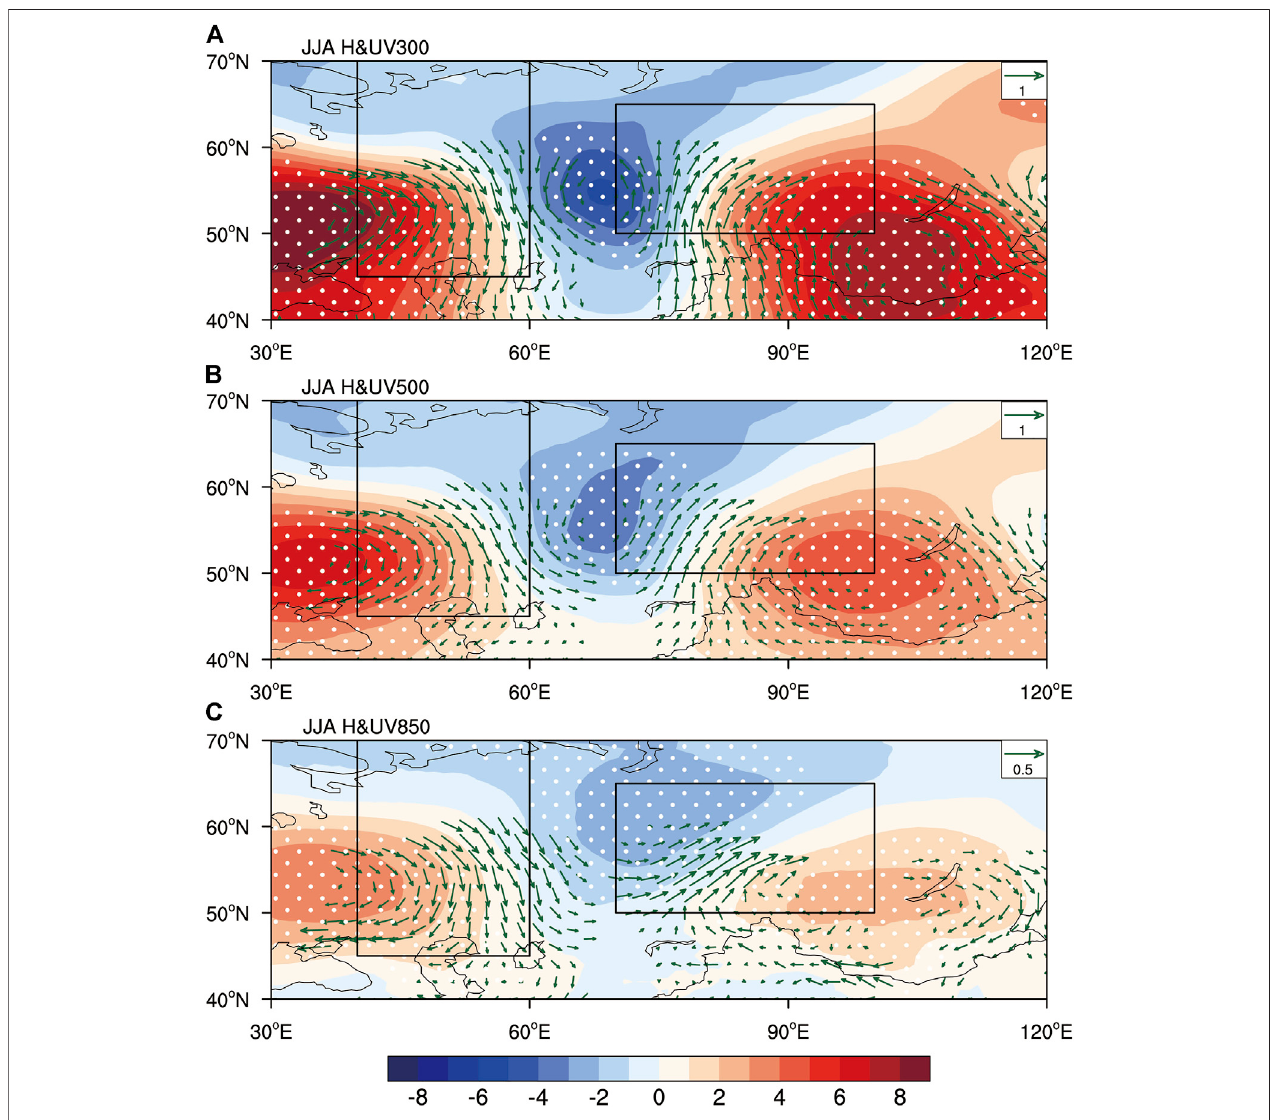
Figure 11A . Four ascending/descending air fl ows and the formed meridional circulation are found over Eastern China and commendably correspond to the quadrupole distribution of ECSP, which is consistent with the above results. Above all, under the background of mid- and upper-level atmospheric circulation anomalies, which are characterized as dipole patterns, a quadrupole pattern of secondary circulation shown in Figure 11A can be found through the lower-level/upper-level convergent/divergent activities and the related ascending/descending